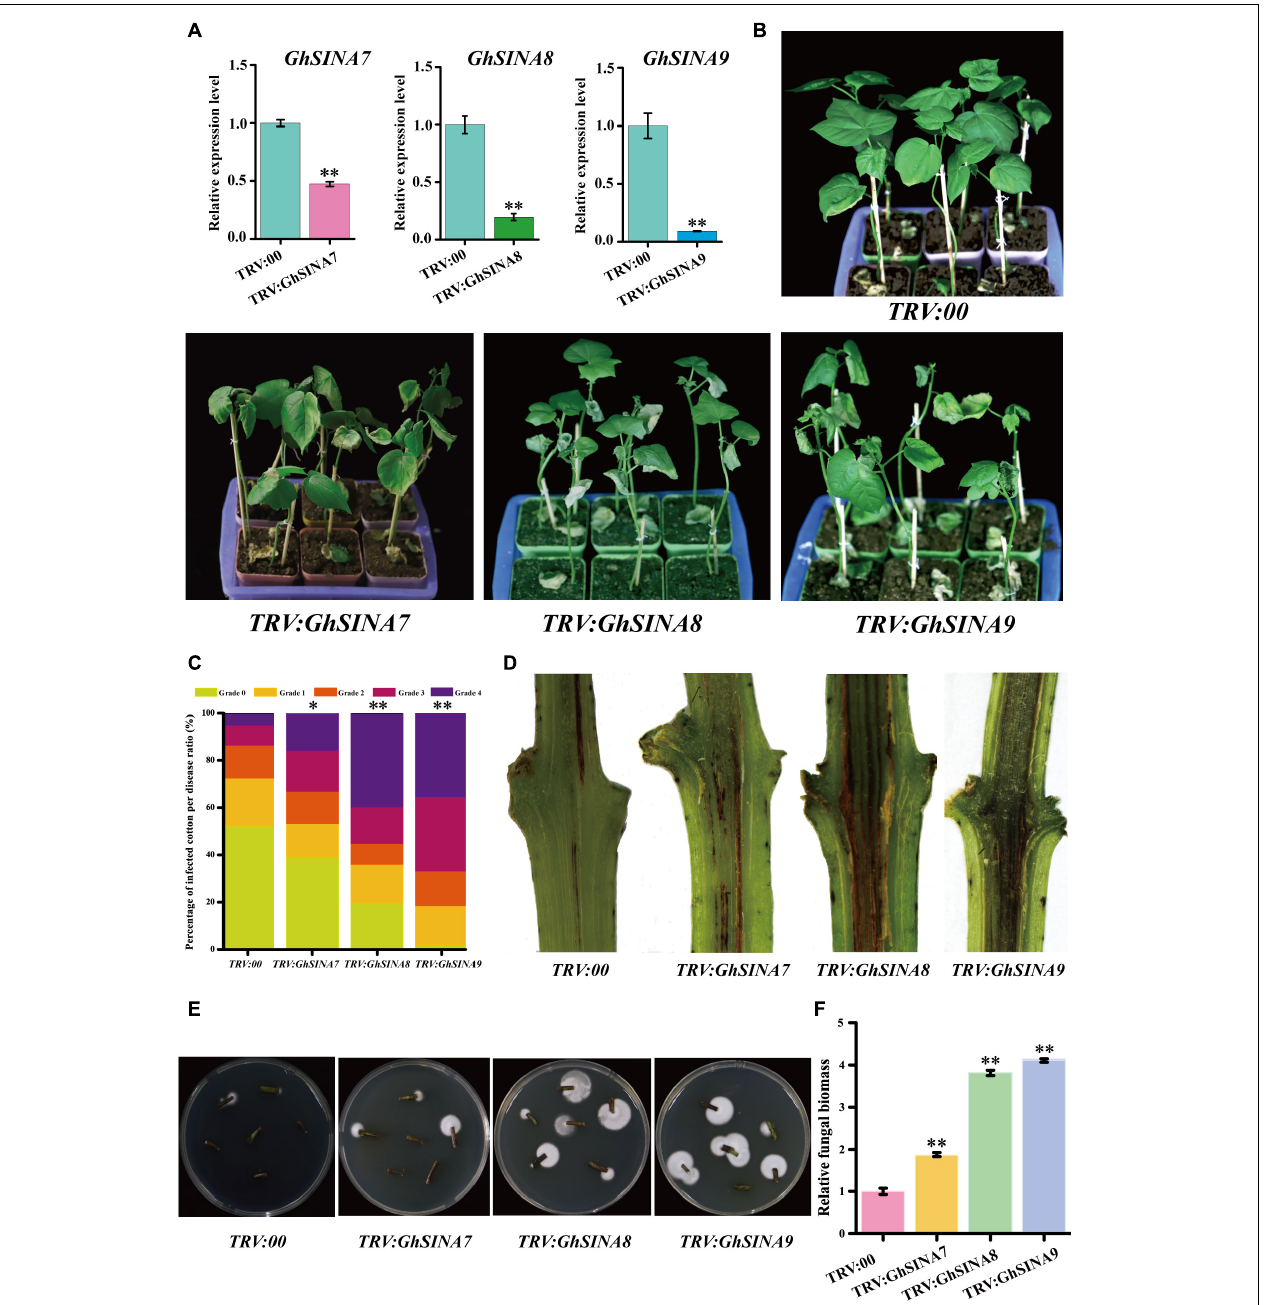
FIGURE 6 | Silencing the GhSINA7 , GhSINA8, or GhSINA9 gene increased susceptibility to V. dahliae in cotton. (A) Transcript levels, as assessed by qRT-PCR, confirmed the silencing of GhSINA7 , GhSINA8, and GhSINA9 in different VIGS plants. Error bars represent the SDs of three biological replicates. Cotton Histone3 was used as an internal control. Asterisks indicate statistically significant differences, as determined by Student’s t -test ( ∗∗ P < 0.01). (B) Disease symptoms of GhSINA7 -, GhSINA8-, and GhSINA9 -silenced plants infected with V. dahliae strain V991 and photographed 14 days after inoculation. (C) The distributions of the disease rank levels. Grade 0: healthy leaves; Grade 1: leaves 0–25% wilted; Grade 2: leaves 25–50% wilted or chlorotic; Grade 3: leaves 50–75% chlorotic or necrotic; Grade 4: leaves dead or detached. The experiments were repeated three times using at least 40 seedlings per treatment. Asterisks indicate statistically significant differences as determined by the Wilcoxon rank-sum test ( ∗ P < 0.05, ∗∗ P < 0.01). (D) Darkened vascular discoloration of the dissected stems in GhSINA7 -, GhSINA8-, and GhSINA9 -silenced cotton plants compared with the controls ( TRV:00 ) at 14 days after V. dahliae inoculation. (E) Fungal recovery assay. The surface-sterilized stem sections from control and silenced plants at 16 days after V. dahliae infection were cut and plated on potato dextrose agar medium. Photos were taken at 3 days after plating. (F) Relative fungal biomasses of silenced plants and controls 14 days after V. dahliae inoculation. The relative biomass represents a comparison of the DNA levels between the V. dahliae internal transcribed spacer (ITS) region and the cotton Histone3 by qRT-PCR analysis. Values represent the means ± SDs from three biological replicates ( ∗∗ P < 0.01, Student’s t -test).